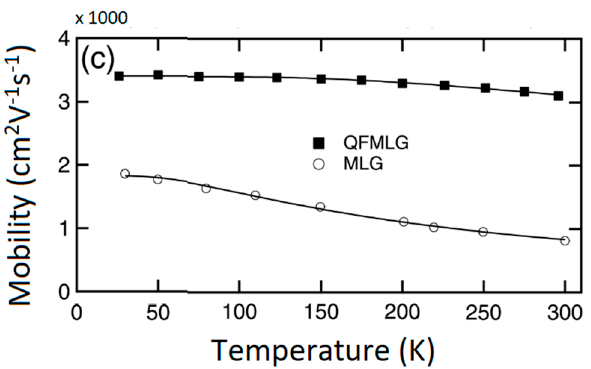
Figure 18. Temperature dependent mobility of QFMLG ( p = 5.7 × 10 12 cm − 2 ) and MLG (10 13 cm − 2 ). Reprinted with permission from Reference [129]. Copyright (2011) AIP Publishing.